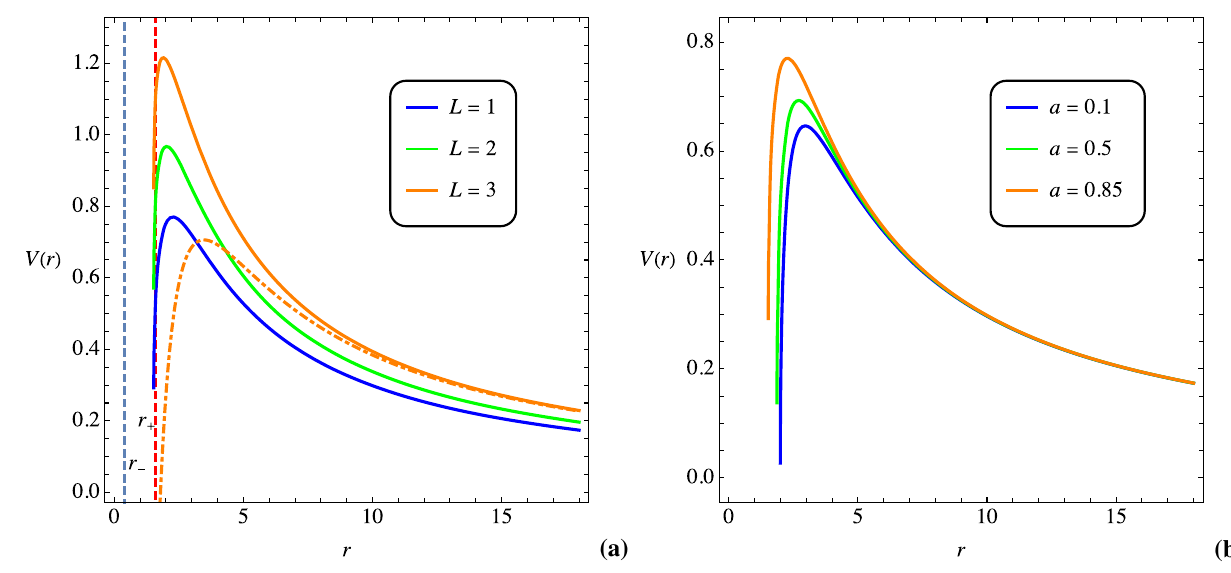
Fig. 1 The radial effective potential in an inhomogeneous anisotropic plasma in the region r > r + , plotted for Q = 9 M 2 and f r = 1 M 2 . The diagrams have been generated for a a = 0 . 85 M and three different values of L (the solid lines), and b L = 1 M and three different values of